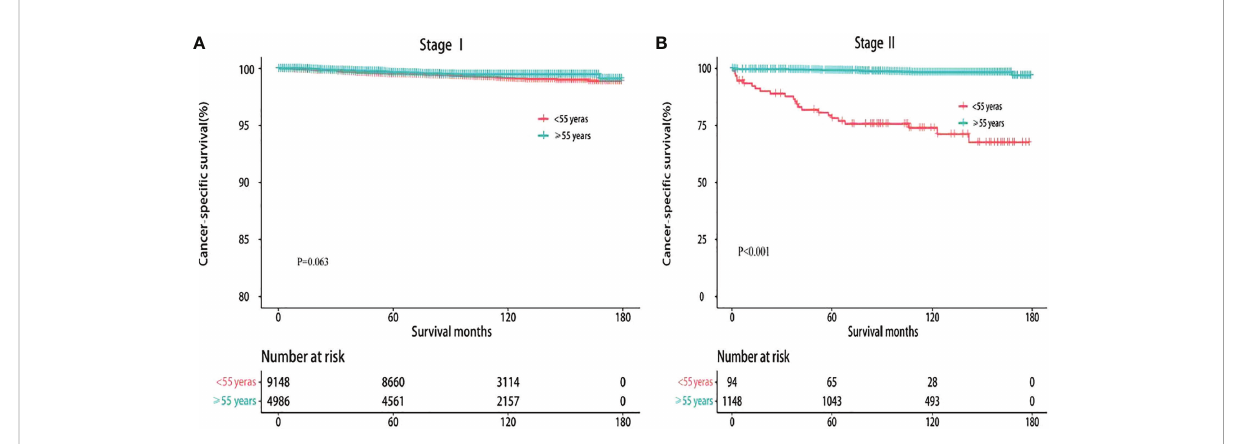
FIGURE 1 Kaplan – Meier survival curves of cancer-speci fi c survival based on the current TNM-8. (A) Stage I. (B) Stage II.